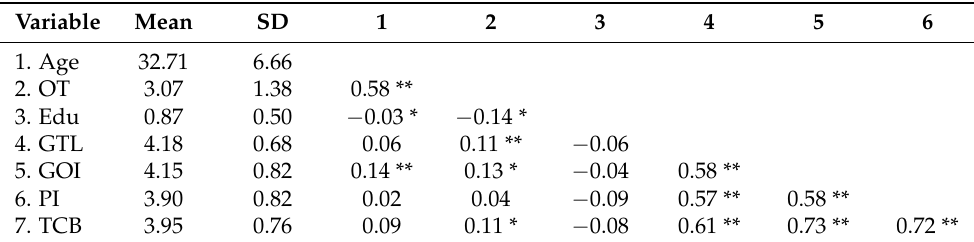
Table 1. Means, standard deviations and interrelations of variables.